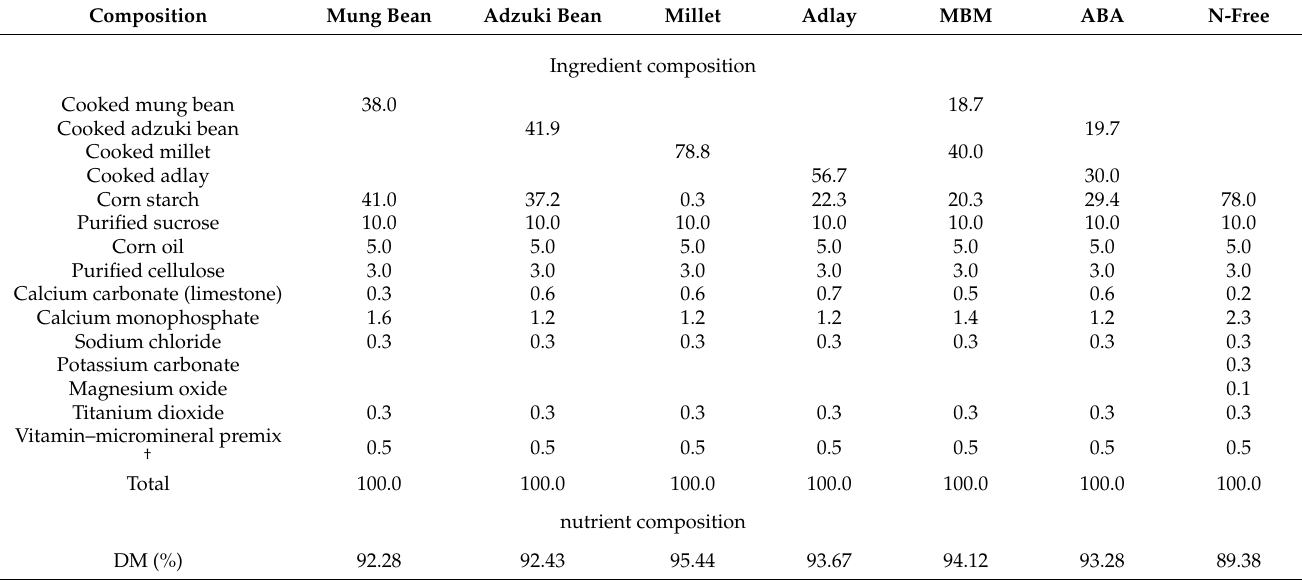
Table 4. Ingredient and nutrient composition of the experimental diets (g/100 g as fed basis). Composition Mung Bean Adzuki Bean Millet Adlay MBM ABA N-Free Ingredient